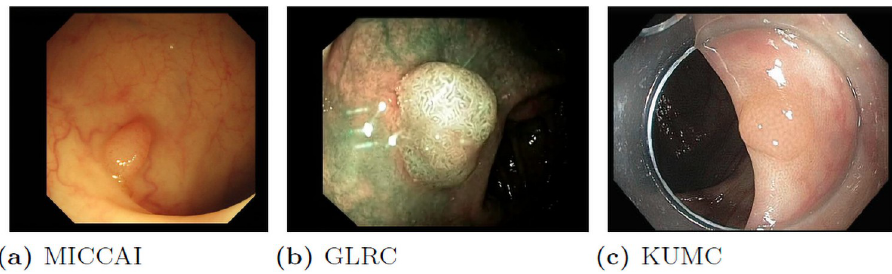
Fig 5. Sample frames from different colonoscopy. (a) has a higher resolution and a warm color temperature; (b) has lower resolution and a green tone; (c) is more natural in color tone but has a transparent cover around the frame